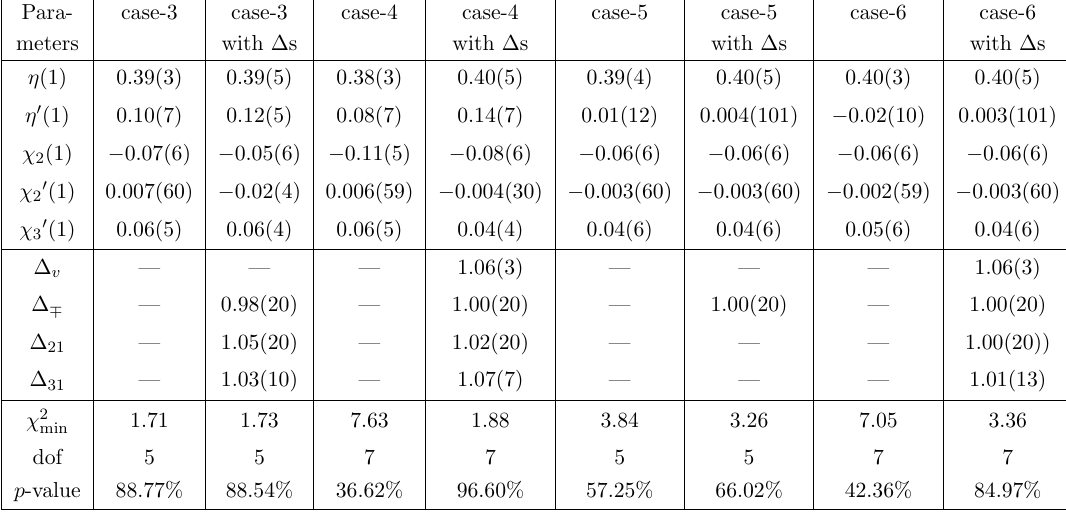
(1) and (cid:31) 0 (1) 2 3